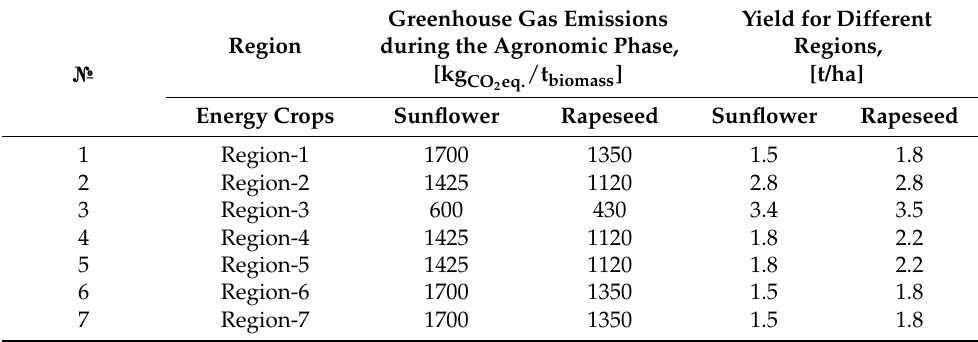
Table 1. Greenhouse gas emissions in the agronomic phase and potential rapeseed yields and sunflower in the regions of Bulgaria